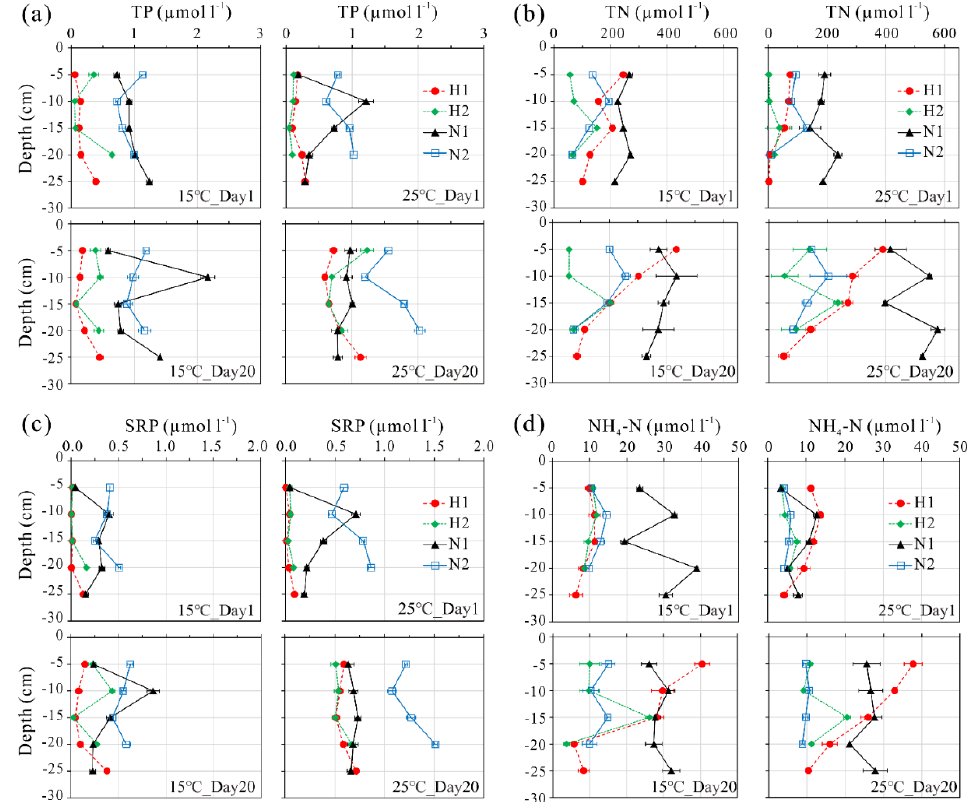
Figure 3. Concentrations of ( a ) dissolved total P (TP), ( b ) total N (TN), ( c ) soluble reactive P (SRP), and ( d ) ammonium (NH 4 -N) in the water overlying sediments incubated at 15 ◦ C and 25 ◦ C for 1 (Day 1) and 20 days (Day 20), by depth, at each sampling site (H1, H2, N1, and N2). Apparent fluxes of TP, SRP, TN, and NH 4 -N were higher at 25 ◦ C than at 15 ◦ C for most sediments (Figures 4 and 5). Mean apparent fluxes of TP and SRP of all sediments from two sites in HCJ and NWL were 22.5 and 33.4 µ mol m − 2 at 15 ◦ C, respectively, compared to 131.5 and 108.1 µ mol m − 2 at 25 ◦ C, respectively. Mean apparent fluxes of TN and NH 4 -N of all sediments from two sites in HCJ and NWL were 14.9 and 0.9 mmol m − 2 at 15 ◦ C, respectively, compared to 38.1 and 2.5 mmol m − 2 at 25 ◦ C, respectively (Figure 5). There was no obvious trend in apparent fluxes of TP, SRP, TN, or NH 4 -N as a function of sediment depth, except for those of TN and NH 4 -N at H1 at both 15 ◦ C and 25 ◦ C (Figure 4b). There were no obvious differences in apparent fluxes of TP, SRP, TN, or NH 4 -N